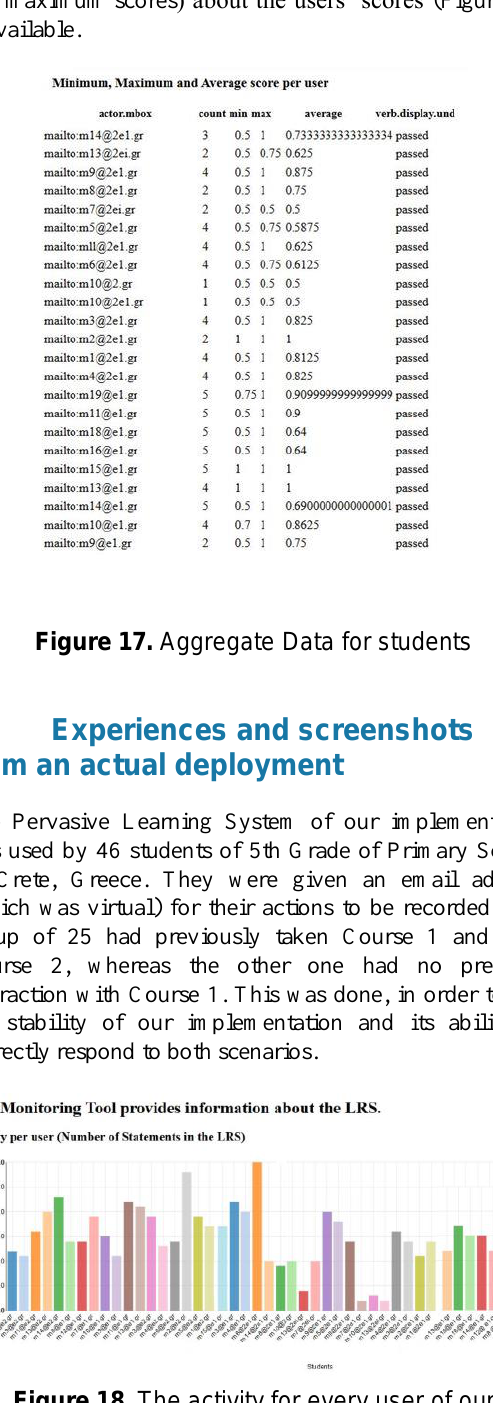
Figure 18. The activity for every user of our